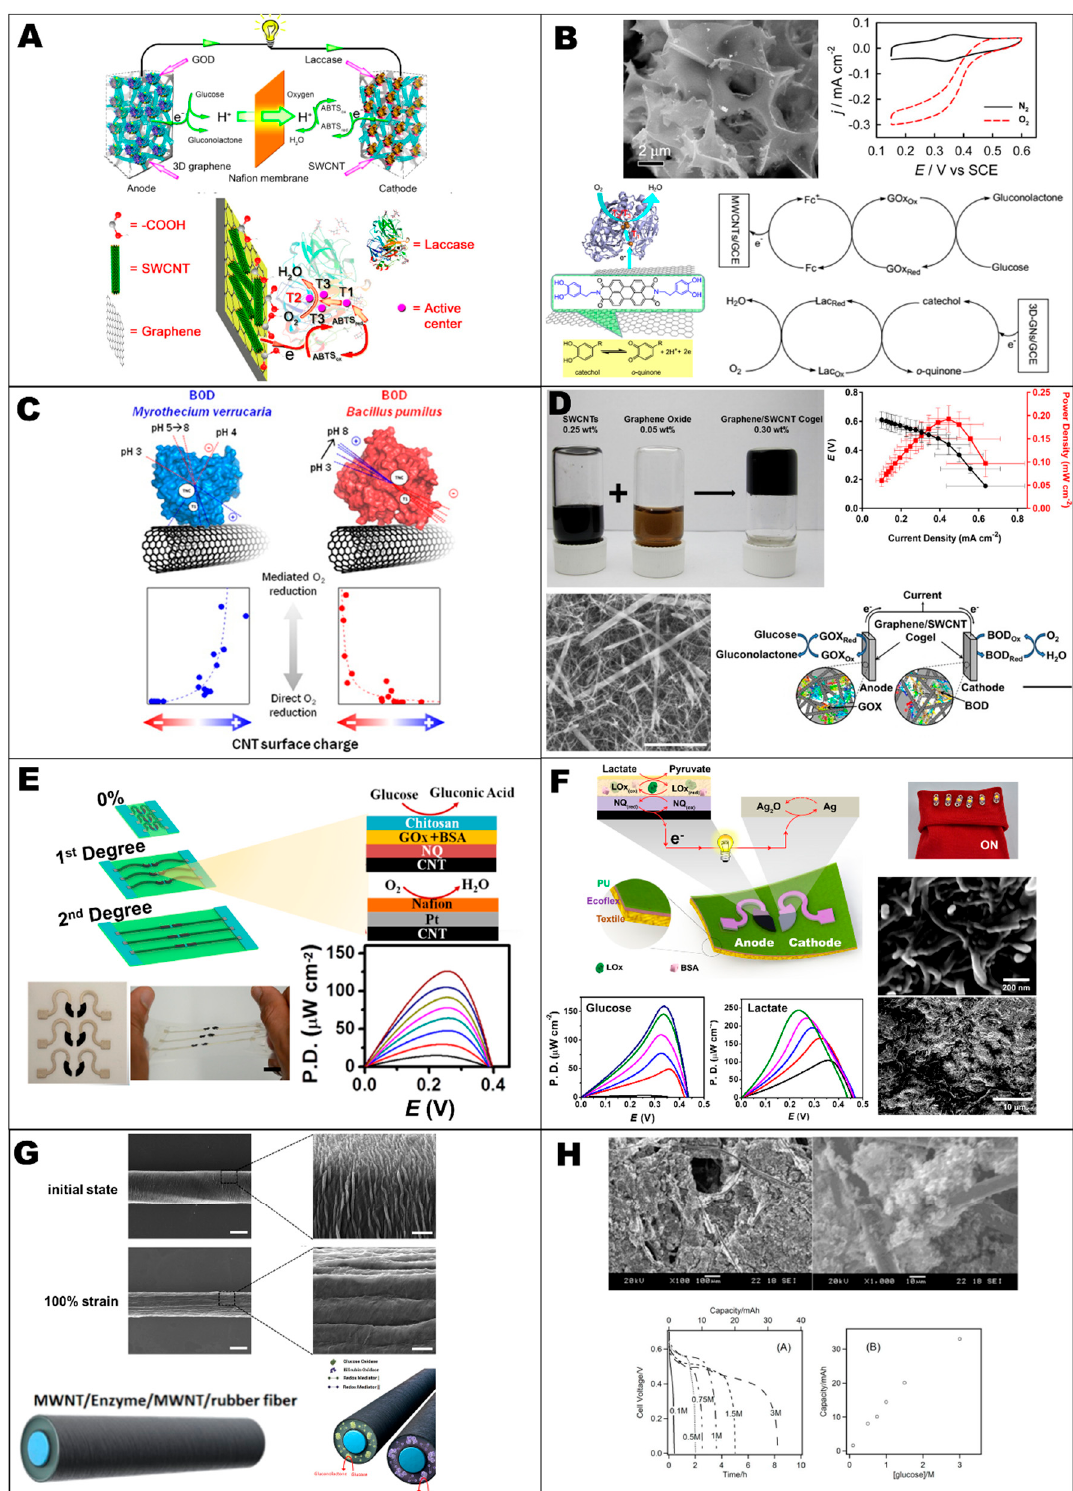
Figure 5. Examples of applications of carbon materials for biofuel cells (BFCs) and potential opportunities toward the development of personalized BFCs. ( A ) 3D graphene-CNT hybrid BFCs. Adapted with permission from [52] , Copyright 2014, American Chemical Society. ( B ) 3D graphene networks as a substrate for immobilization of enzymes for BFCs. Adapted with permission from [53] , Copyright 2014, American Chemical Society. ( C ) Study of interactions between CNTs and bilirubin